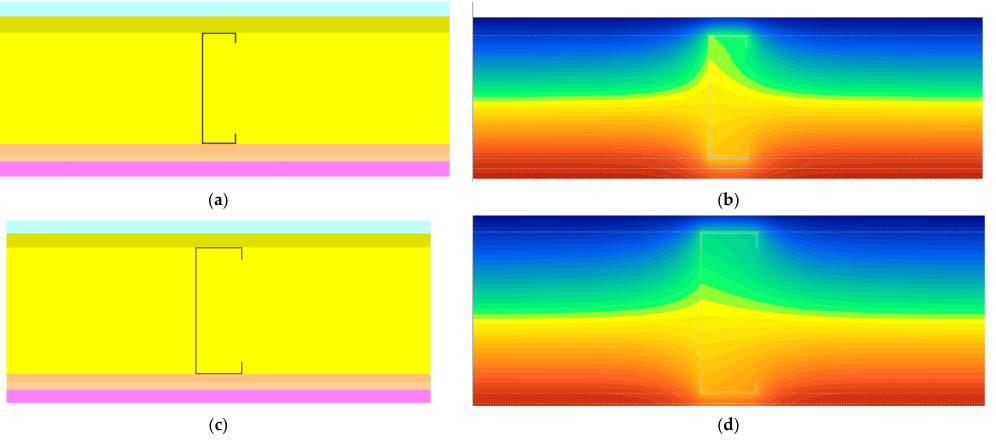
Figure A1. Exterior wall current field-Geometrical models ( a ) east and west, ( c ) north; Isothermal surfaces ( b ) east and west, ( d ) north .